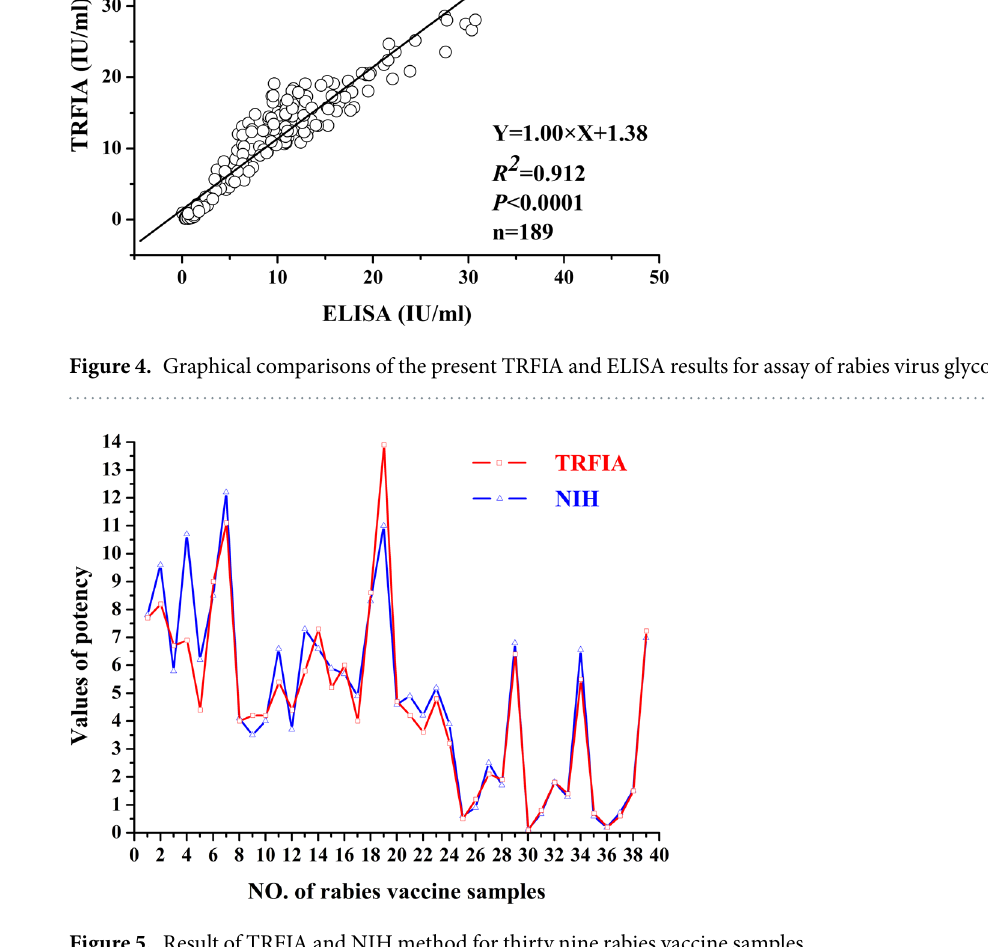
Figure 5. Result of TRFIA and NIH method for thirty nine rabies vaccine samples.